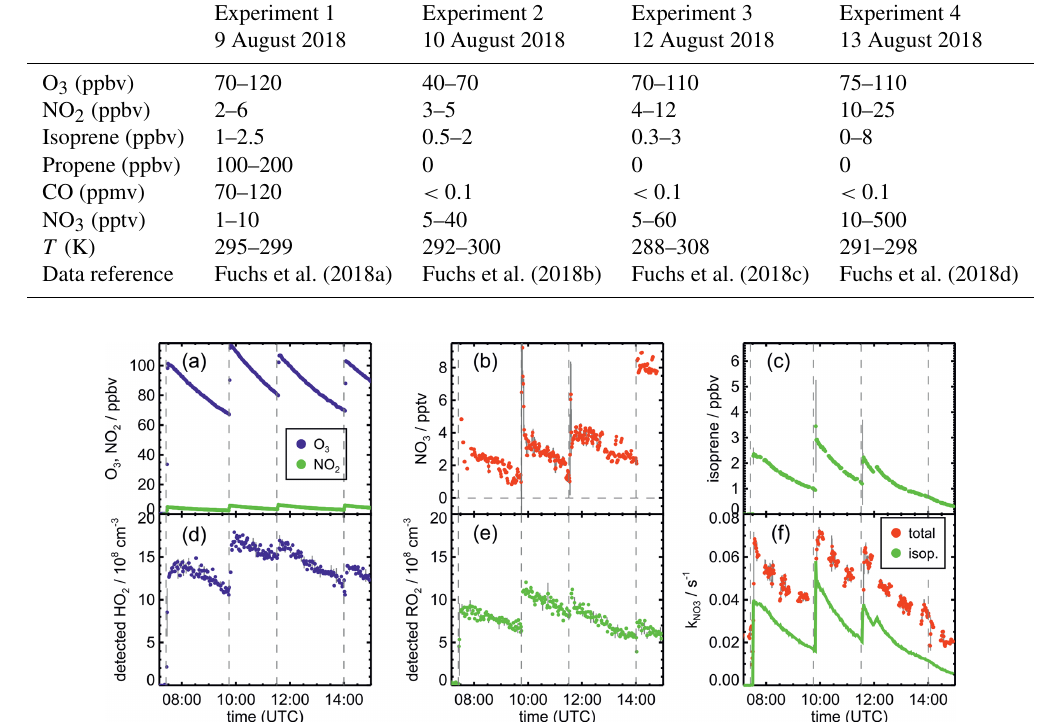
Table 1. Chemical conditions in the experiments in this work. Experiments analysed in this work were performed in dry air. Mixing ratios of trace gases give the range of values reached immediately after their injection.